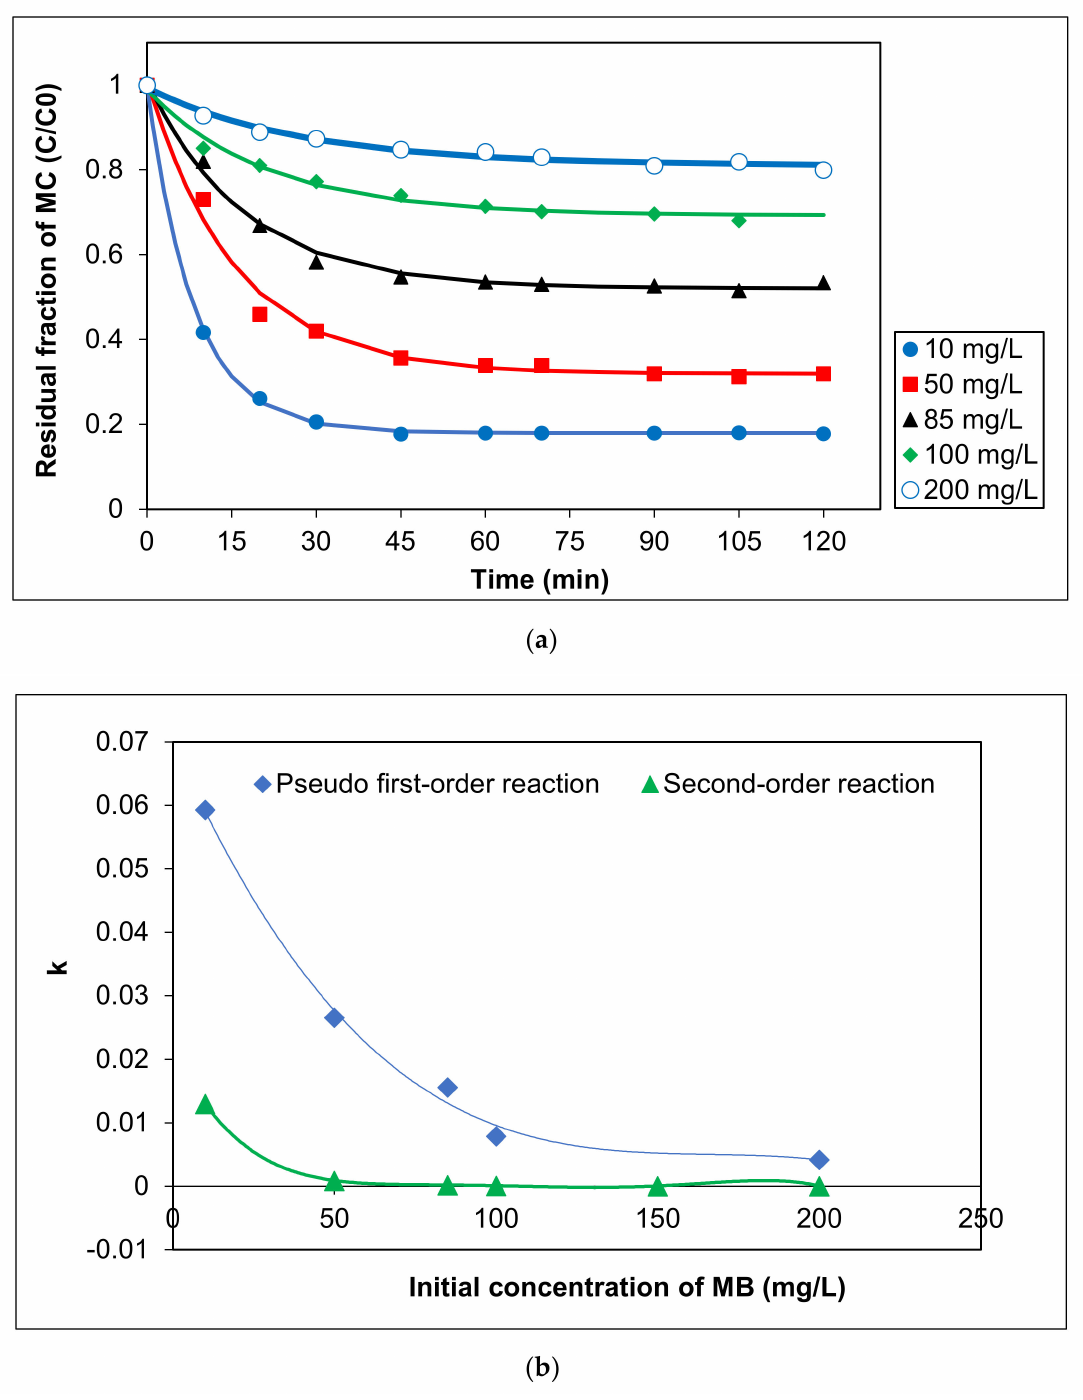
Figure 5. Effect of different initial concentrations of MC on ( a ) residual fraction of MC with time using Ag/AgCl-G and ( b ) relation of kinetic constants (k) with different initial concentration of MC (pH = 10, and Ag/AgCl-G loading = 0.4 g L − 1